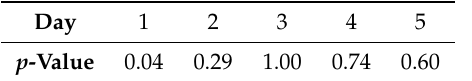
Table 3. Pairwise accuracy comparison between tDCS and sham group.